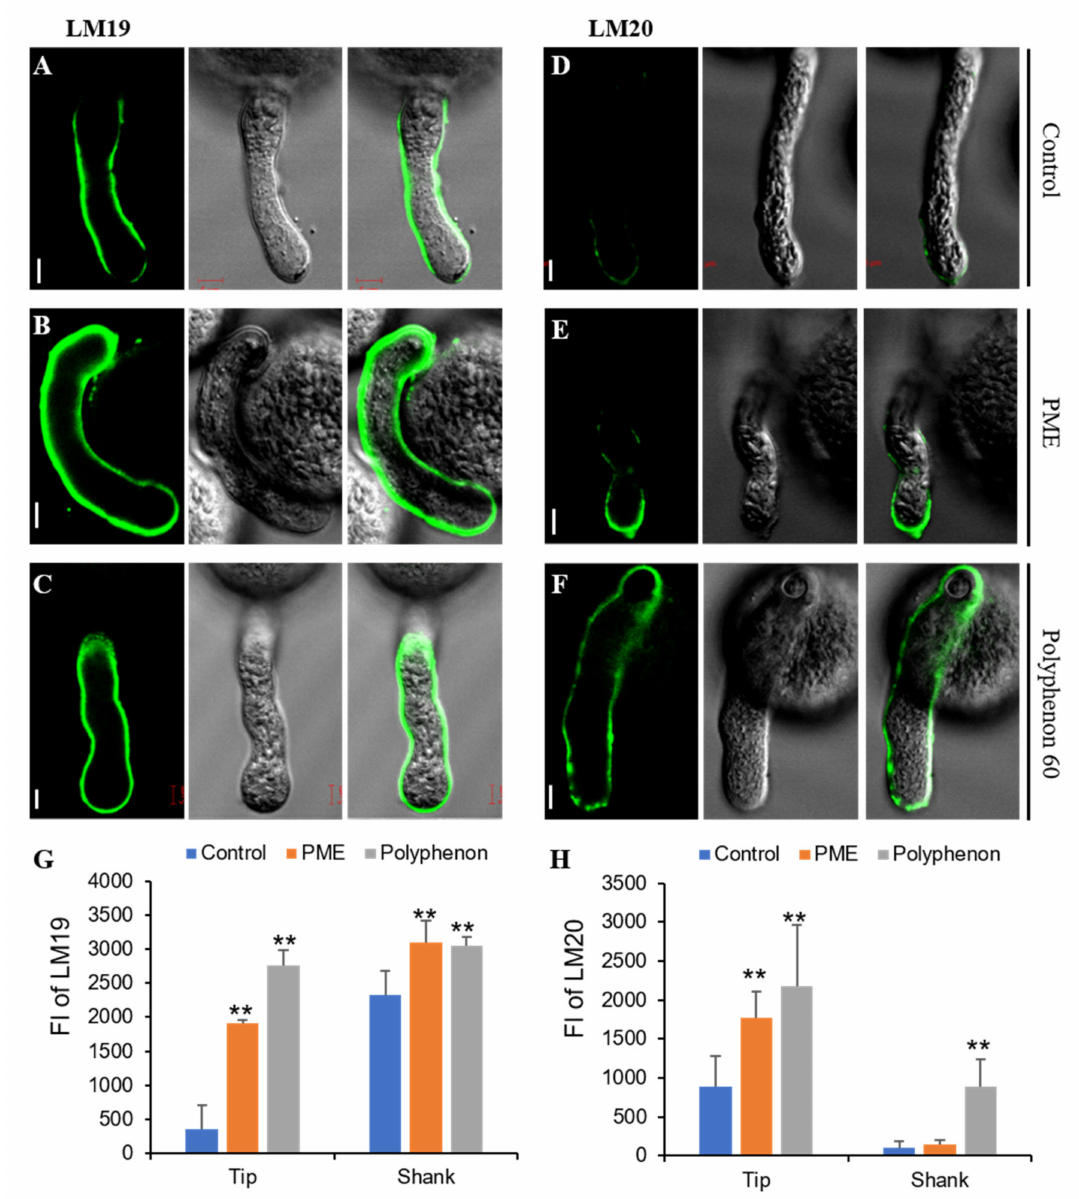
Figure 3. Immunodetection of pectins during pollen germination. Pollen tubes were probed with the monoclonal antibodies LM19 and LM20. LM19 is used to indicate pectins with a low level of methylesterification whereas LM20 binds to pectins with a high level of methylesterification. ( A ) Control: fluorescent signals of dimethyl-esterified pectin. ( B ) Fluorescent signals of dimethyl-esterified pectin of the PME-treated pollen tube. ( C ) Fluorescent signals of the dimethyl-esterified pectin of Polyphenon 60-treated pollen tube. ( D ) Control: fluorescent signals of methyl-esterified pectin. ( E ) Fluorescent signals of methyl-esterified pectin of the PME-treated pollen tube. ( F ) Fluorescent signals of methyl-esterified pectin of the Polyphenon 60-treated pollen tube. Moderate concentration of PME (2 · U / mL) was added onto the germination medium. ( G ) Quantification analysis of fluorescent signals of dimethyl-esterified pectin on the pollen tube tip and shank. ( H ) Quantification analysis of fluorescent signals of the methyl-esterified pectin on the pollen tube tip and shank. FI, fluorescence intensity. All error bars represent SD of at least twenty independent experiments. Student’s t test: ** p < 0.01. Scale bars = 5 µ